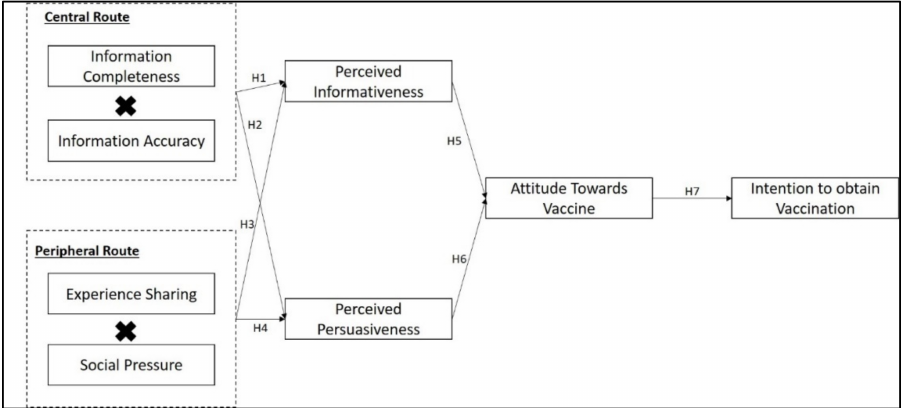
Figure 1. Conceptual framework of the